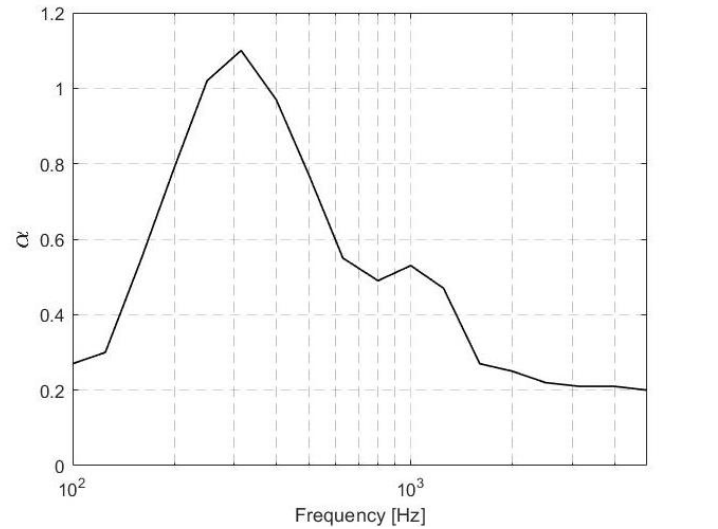
Figure 10. Sound absorption coefficient α of panel AC-T3-BP . A value greater than 1 indicates a not completely diffuse sound field, a typical problem encountered when sound-absorbing material is installed in the reverberation room.